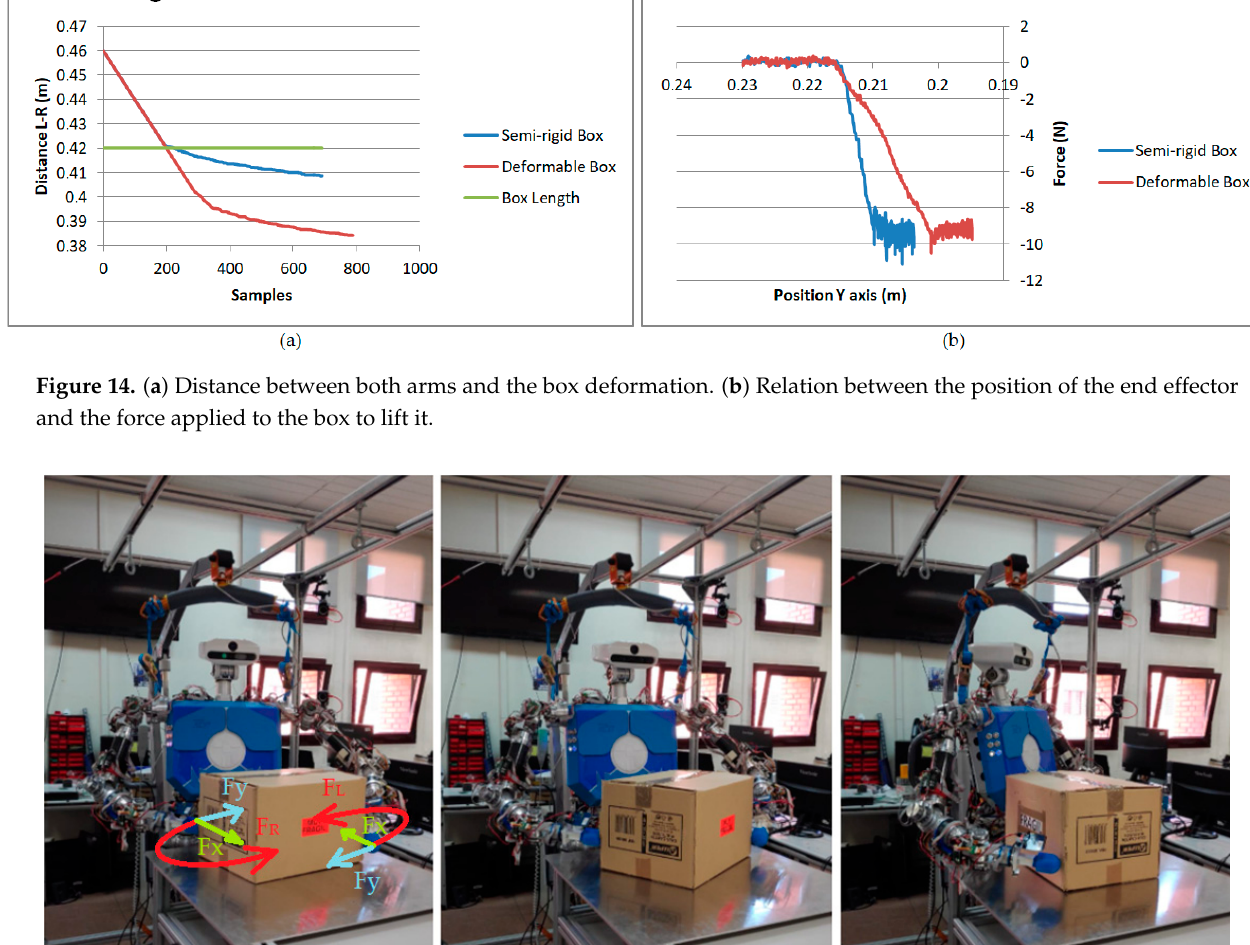
Figure 14. ( a ) Distance between both arms and the box deformation. ( b ) Relation between the position of the end effector and the force applied to the box to lift it.